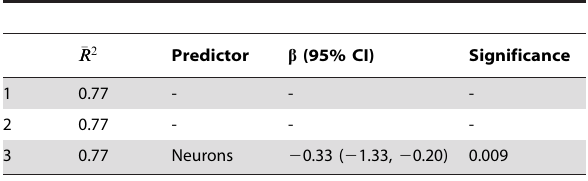
Table 2. Significant predictors of viral non-structural gene substitution